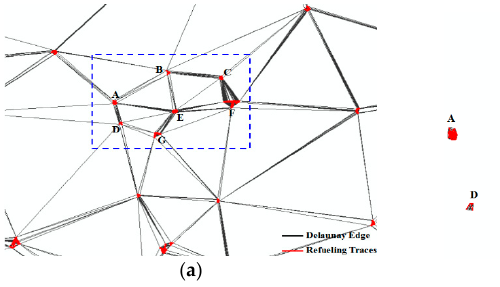
Figure 3. Refueling stop sub-tracks extraction by the Velocity Sequence Linear Clustering (VSLC) algorithm.